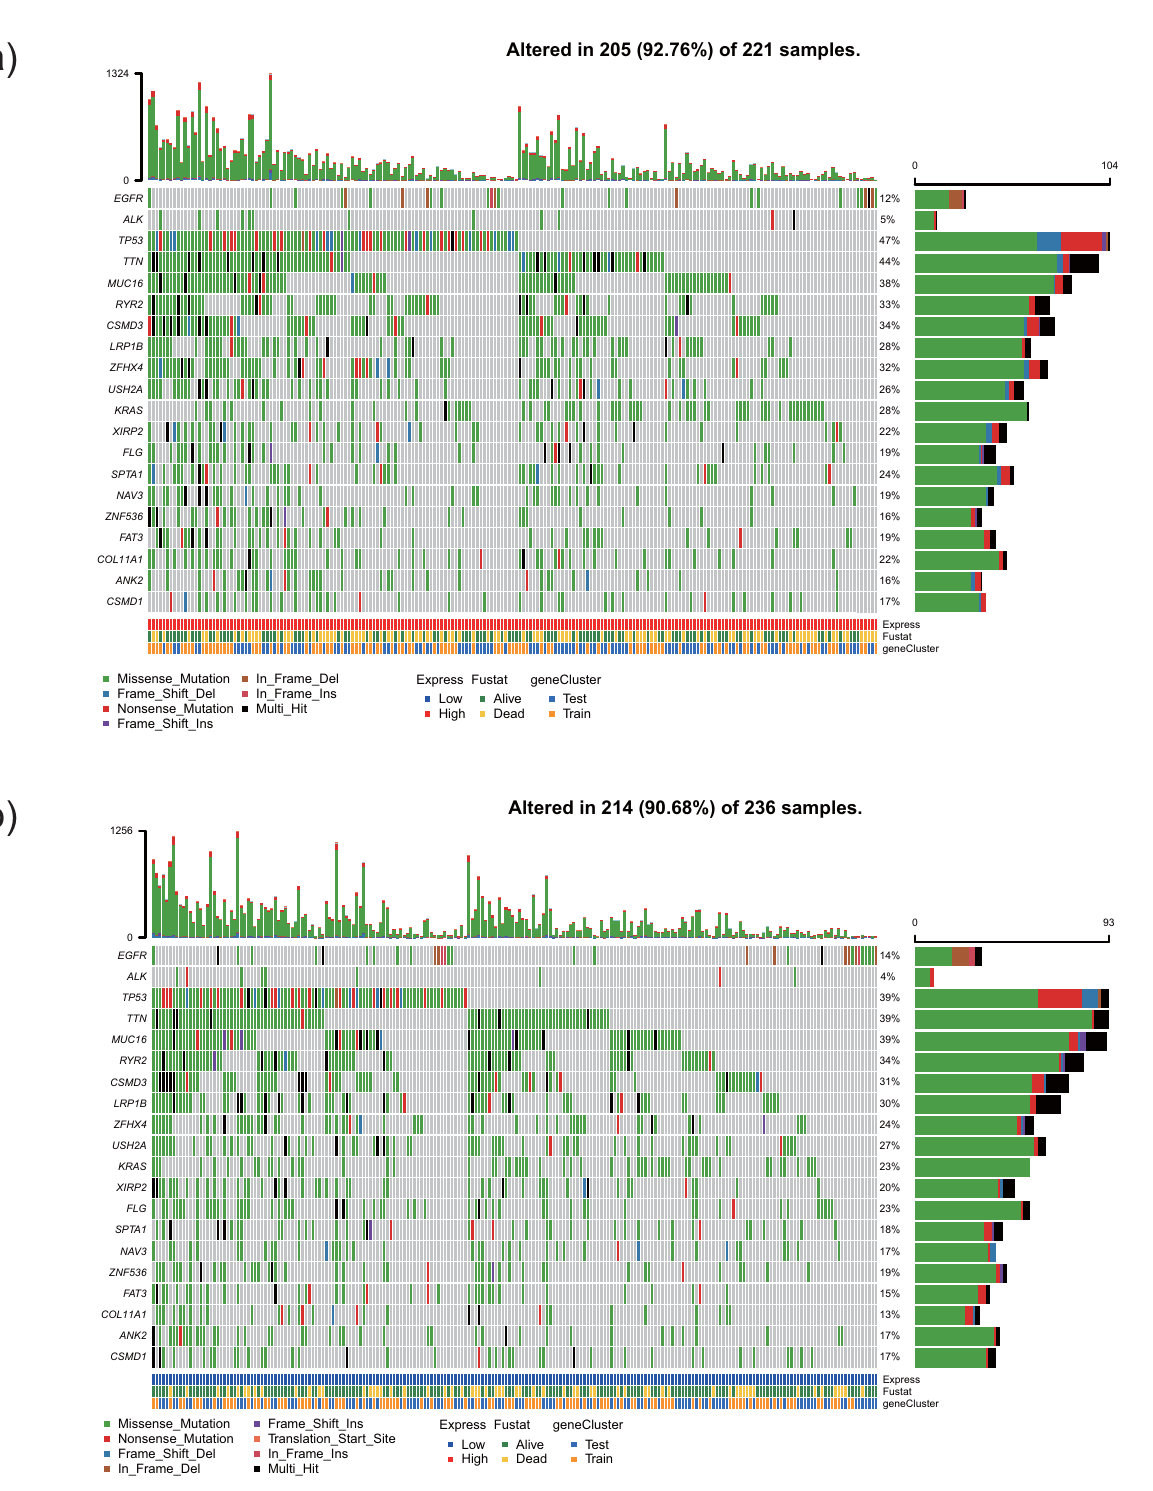
Figure 6: Analysis of somatic mutations in high - risk and low - risk groups. The waterfall plots of the high - ( a ) and low - risk ( b ) groups showing the distribution of mutations in the genes with the highest frequency of mutations. The central panel shows the type of mutation in each sample. The upper panel shows the mutation frequency for each sample. The bar chart on the right shows the frequency and type of mutations. The bottom panel is a legend describing the mutation